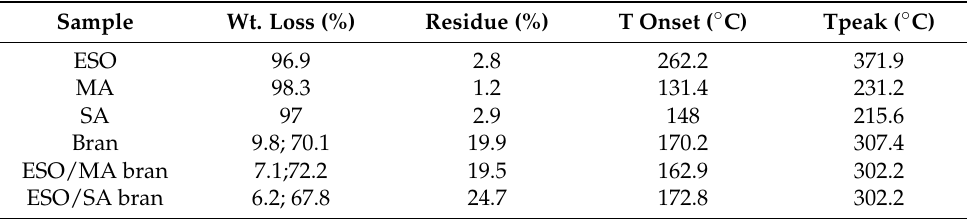
Table 2. Thermogravimetry data regarding reagents, bran and modified